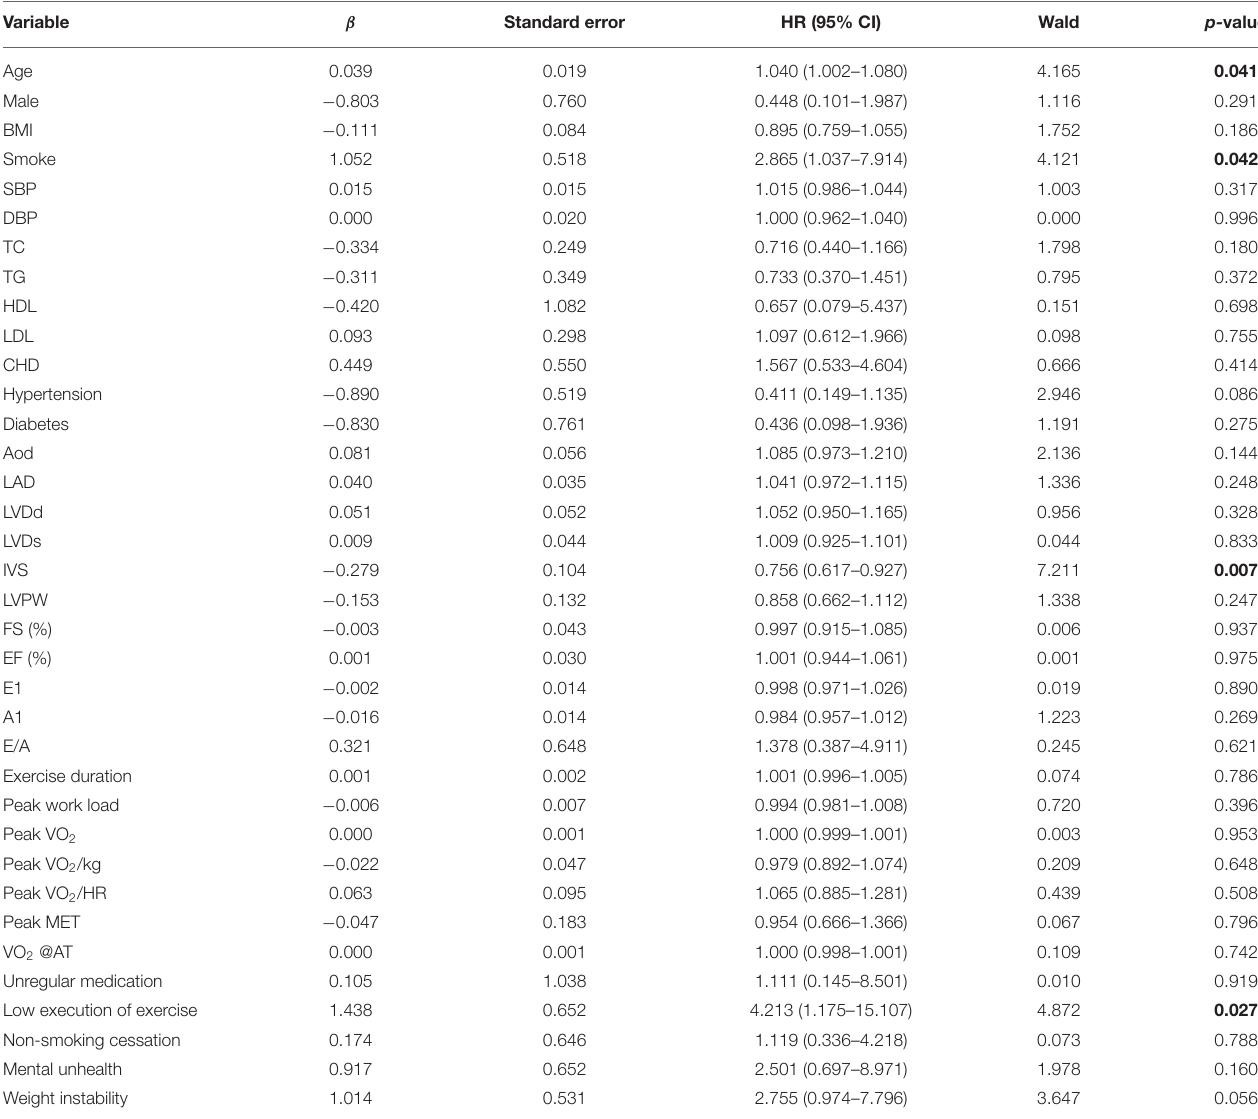
TABLE 4 | Univariate Cox analysis of proportional risks for